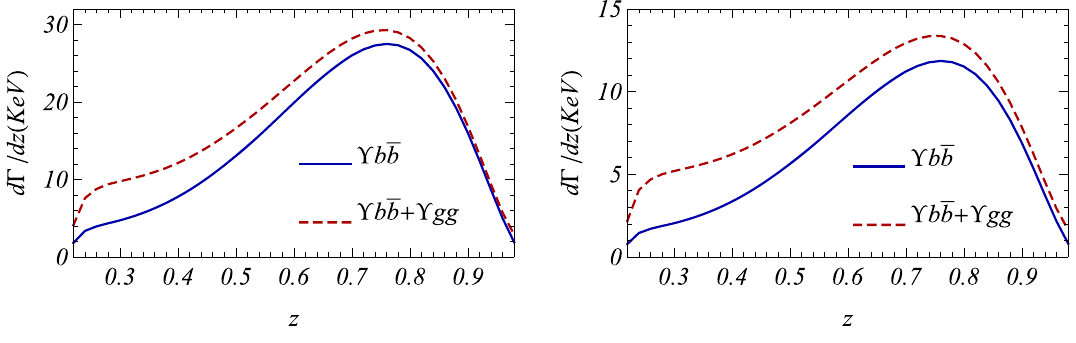
Fig. 6 The differential decay widths. z = 2 E ϒ( 1 S ) and m b = 4 . 9 GeV. μ r = 2 m b in the left diagram, and μ r = m Z in the right diagram. The m Z superscripts “ ϒ gg ” and “ ϒ b ¯ b ” denote the contributions via Z → ϒ( 1 S ) + g + g and Z → ϒ( 1 S ) + b + ¯ b ,